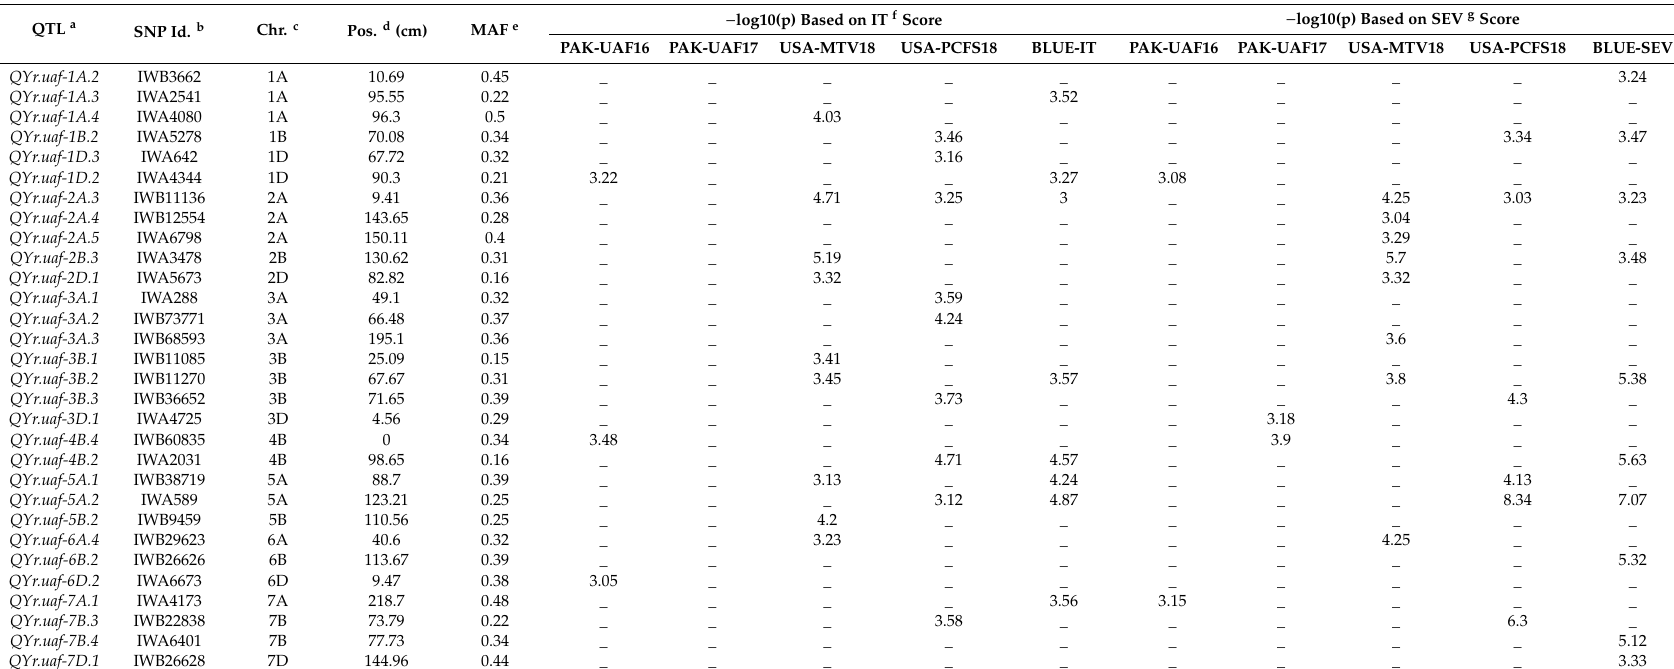
Table 3. SNPs associated with adult plant response (IT and SEV) at three locations with p <